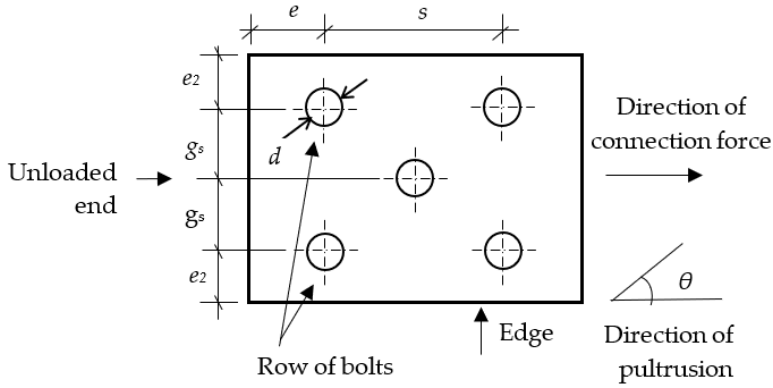
Figure 1. Connection definition. Table 1. Minimum requirements for bolted-connection geometries.